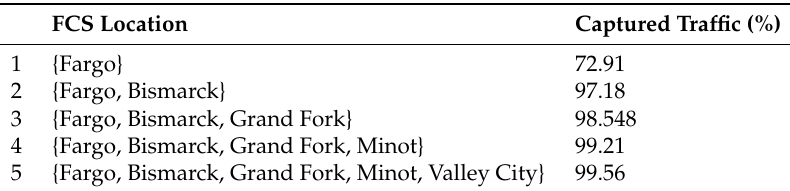
Figure 9. The North Dakota State network [45]. Table 5. Optimal FCS